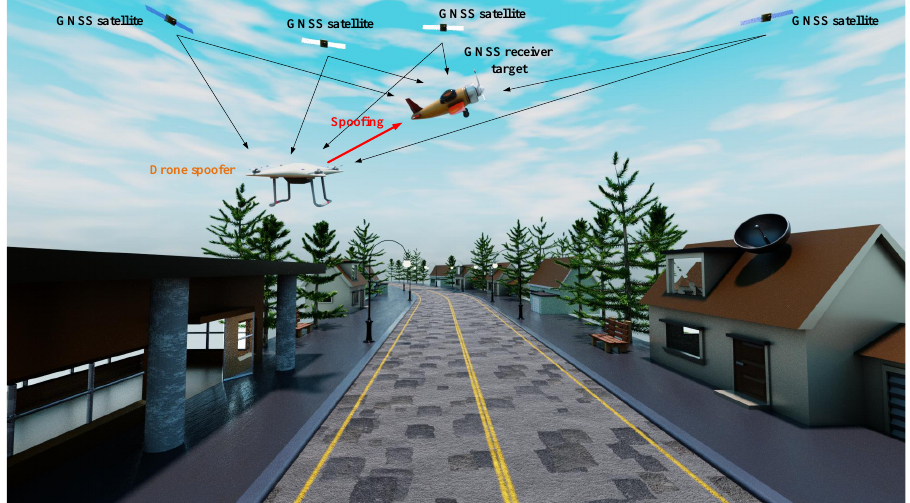
Figure 2. The illustration of a spoofer attacking